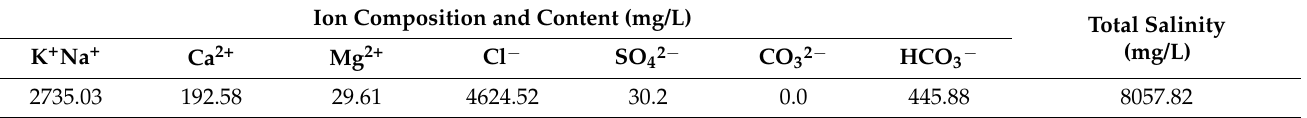
Table 1. Water quality analysis.